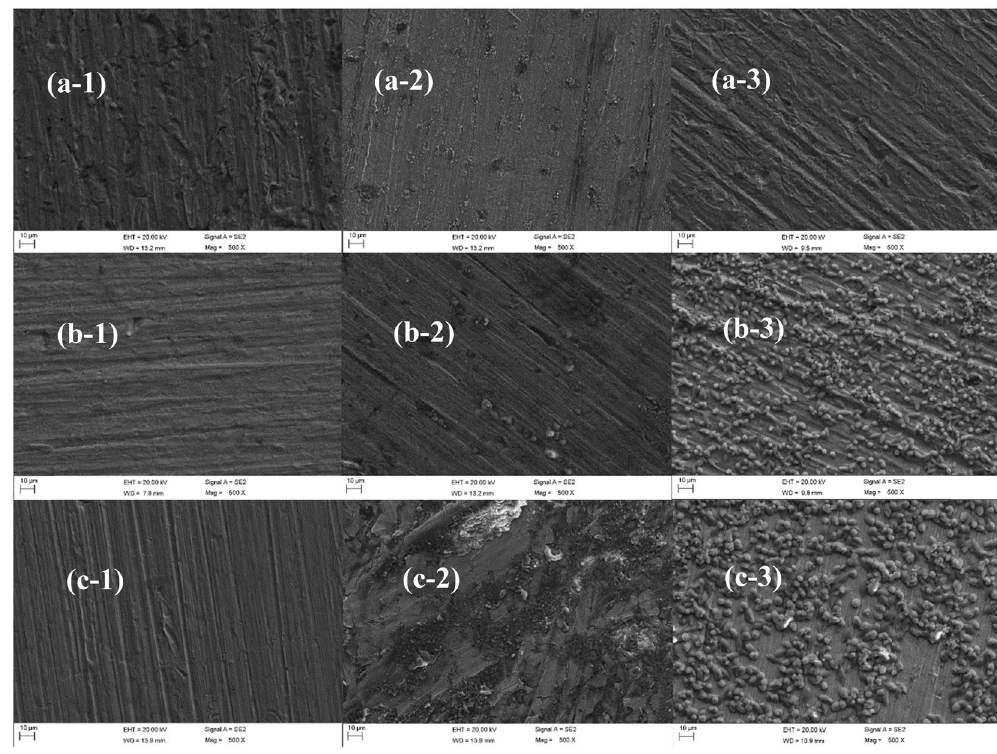
Figure 14. SEM images of three zones under flowing seawater for 12 h: ( a ) BM, ( b ) HAZ, ( c ) WM, (1) 1.85 m/s, (2) 3 m/s, and (3) 6 m/s.